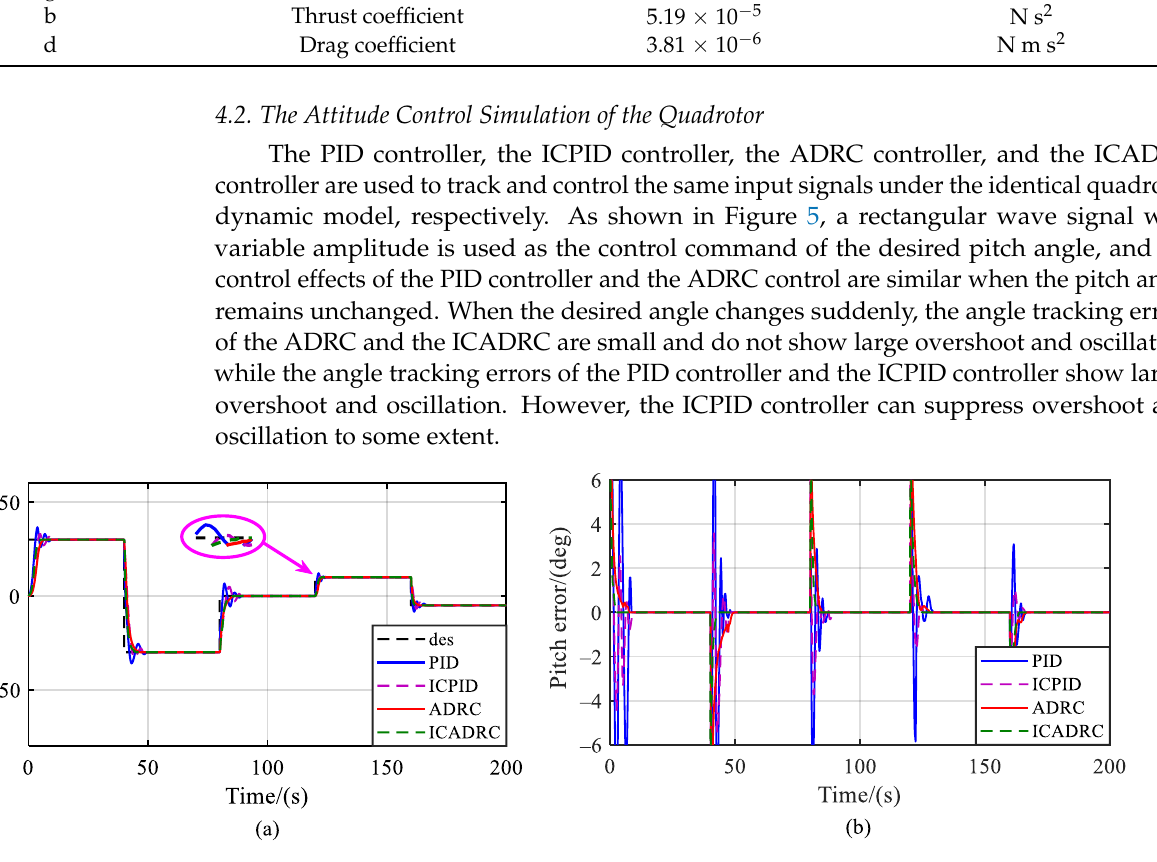
Table 3. Parameters of the test quadrotor.